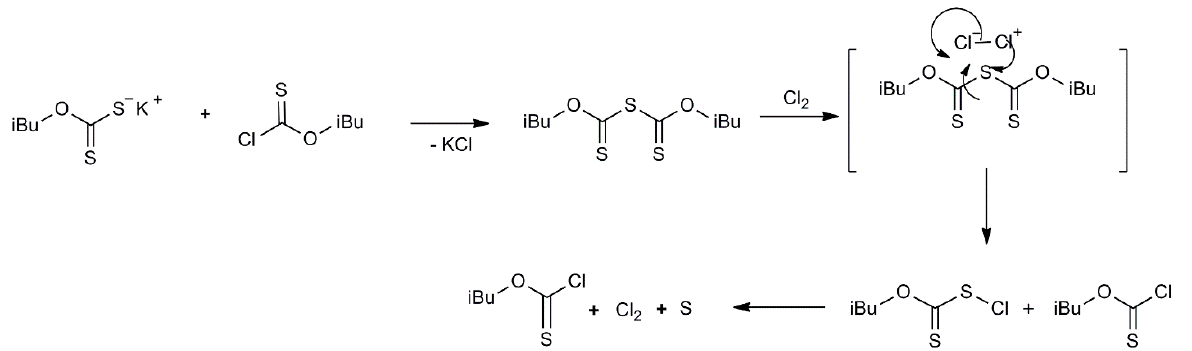
Figure 5. Side reaction mechanism in the course of alkyl thiocarbamate synthesis.